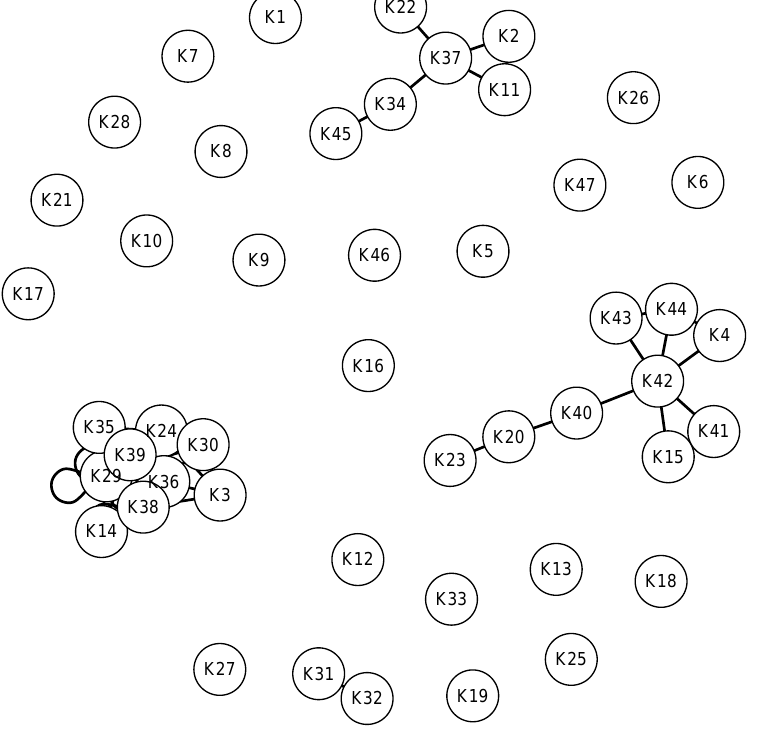
Figure 2. Consonance of the overall impact of concepts using the operator combination T -norm Algebraic product and S -norm Maximum and relevancy threshold of